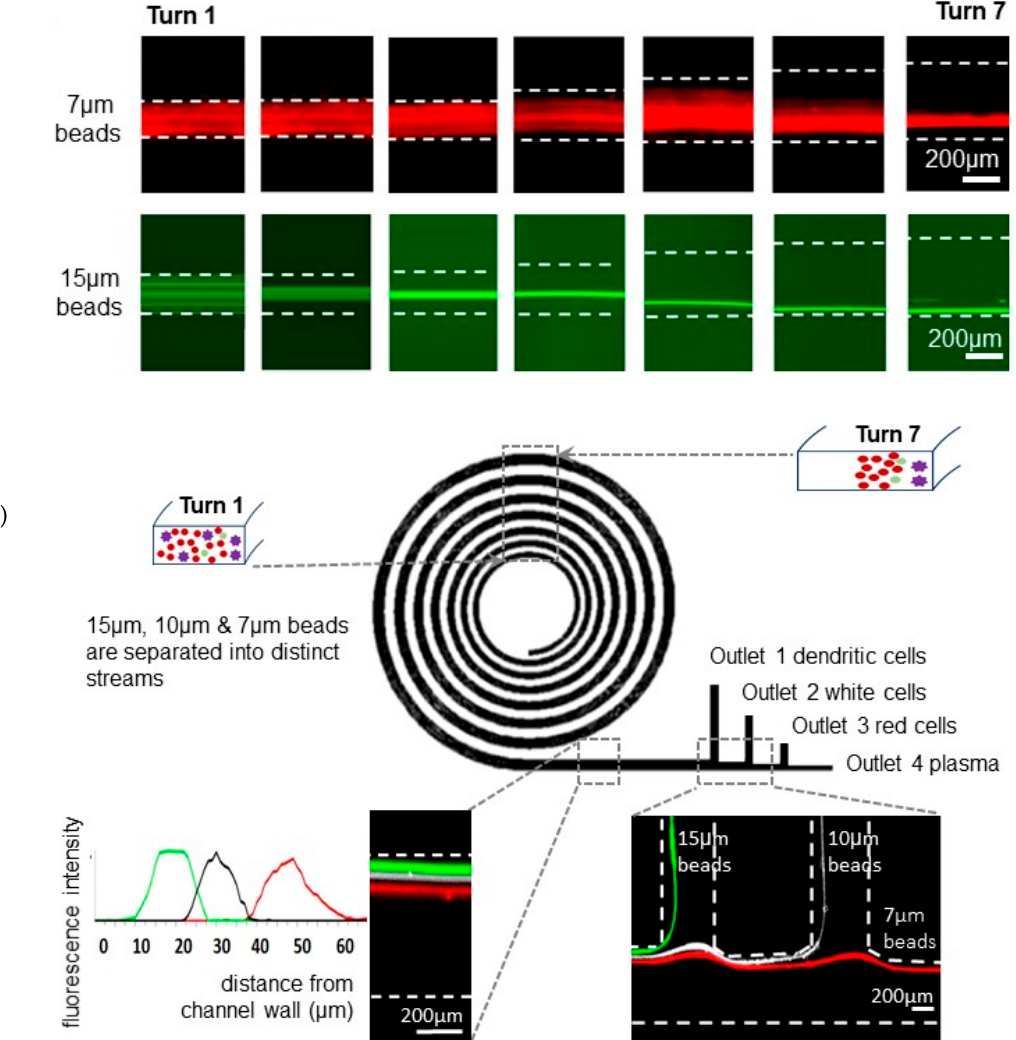
Figure 1. An inertial spiral microfluidic device for separating fluorescent beads of 3 different sizes: ( a ) ( i ) a PDMS device is designed with channel widths exceeding 200 µm, so that the mold can be fabricated with low-cost xurography. Scanning Electron Microscope images of ( ii ) planar and ( iii ) cross-sectional views of the device show that the mold produces smooth channel walls. ( b ) The largest beads (green) are focused at earlier turns of the device, migrate closest to the inner channel wall and are collected at the first outlet. Focused particle streams are spaced closely together.